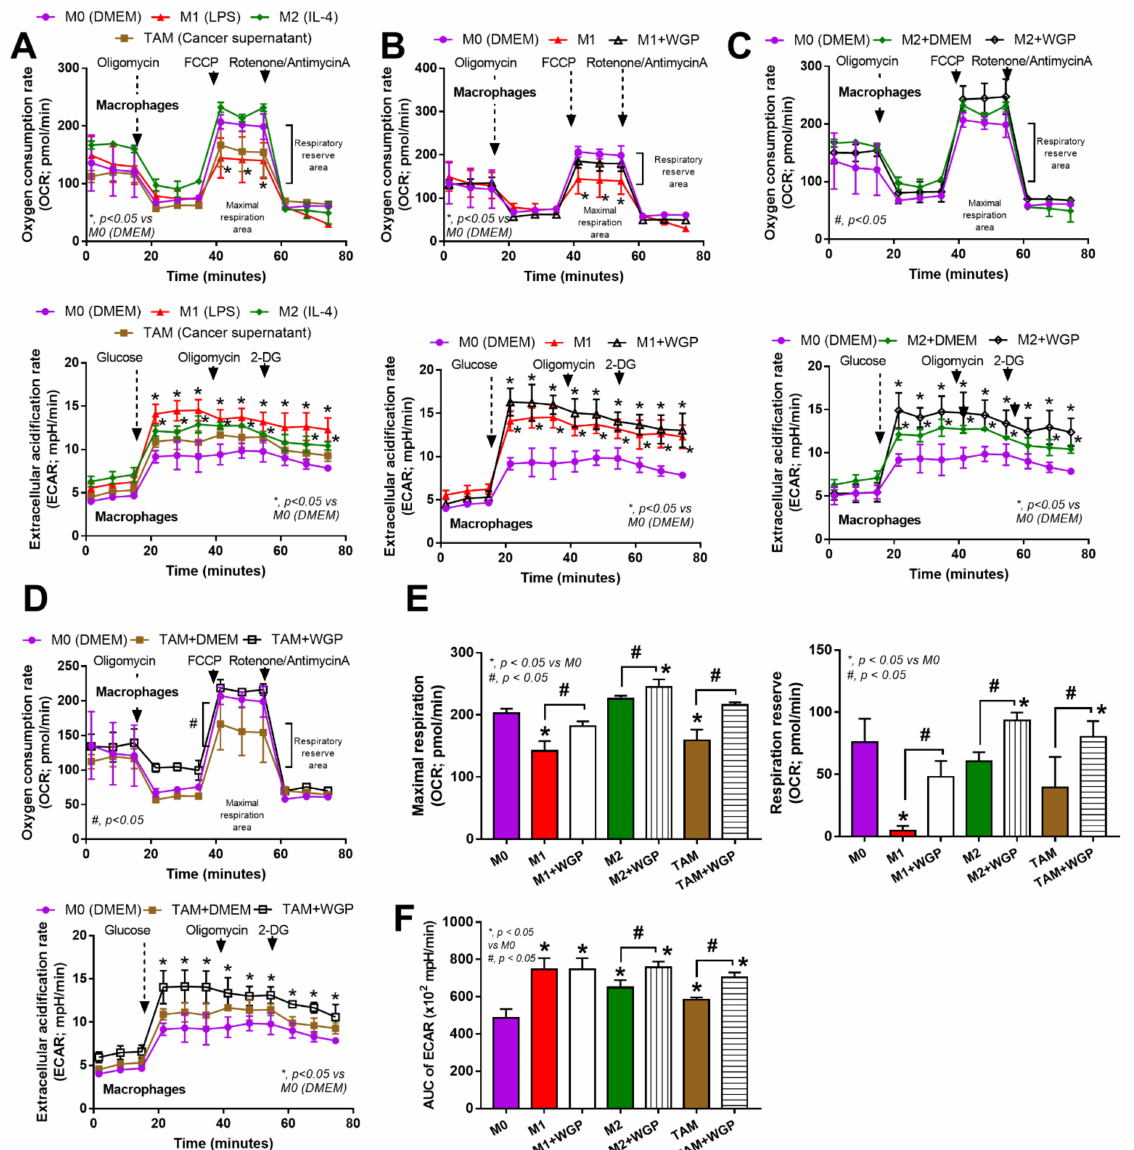
Figure 6. The characteristics of cell energy of bone marrow-derived macrophages from wild-type mice after incubation with DMEM control media (M0), LPS (M1), IL-4 (M2) and the supernatant of cancer cell line (MC38) (tumor-associated macrophages; TAM) with or without the whole glucan particle (WGP), as indicated by graphs of extracellular flux analysis for mitochondrial function (oxygen consumption rate; OCR) and glycolysis activity (extracellular acidification rate; ECAR) ( A – D ), with a graph presentation of cell energy parameters, including mitochondrial functions (maximal respiration and respiratory reserve) ( E ) and area under the curve (AUC) of ECAR (glycolysis activity) ( F ). Independent triplicate experiments were performed. *, p < 0.05 vs. M0; #, p <